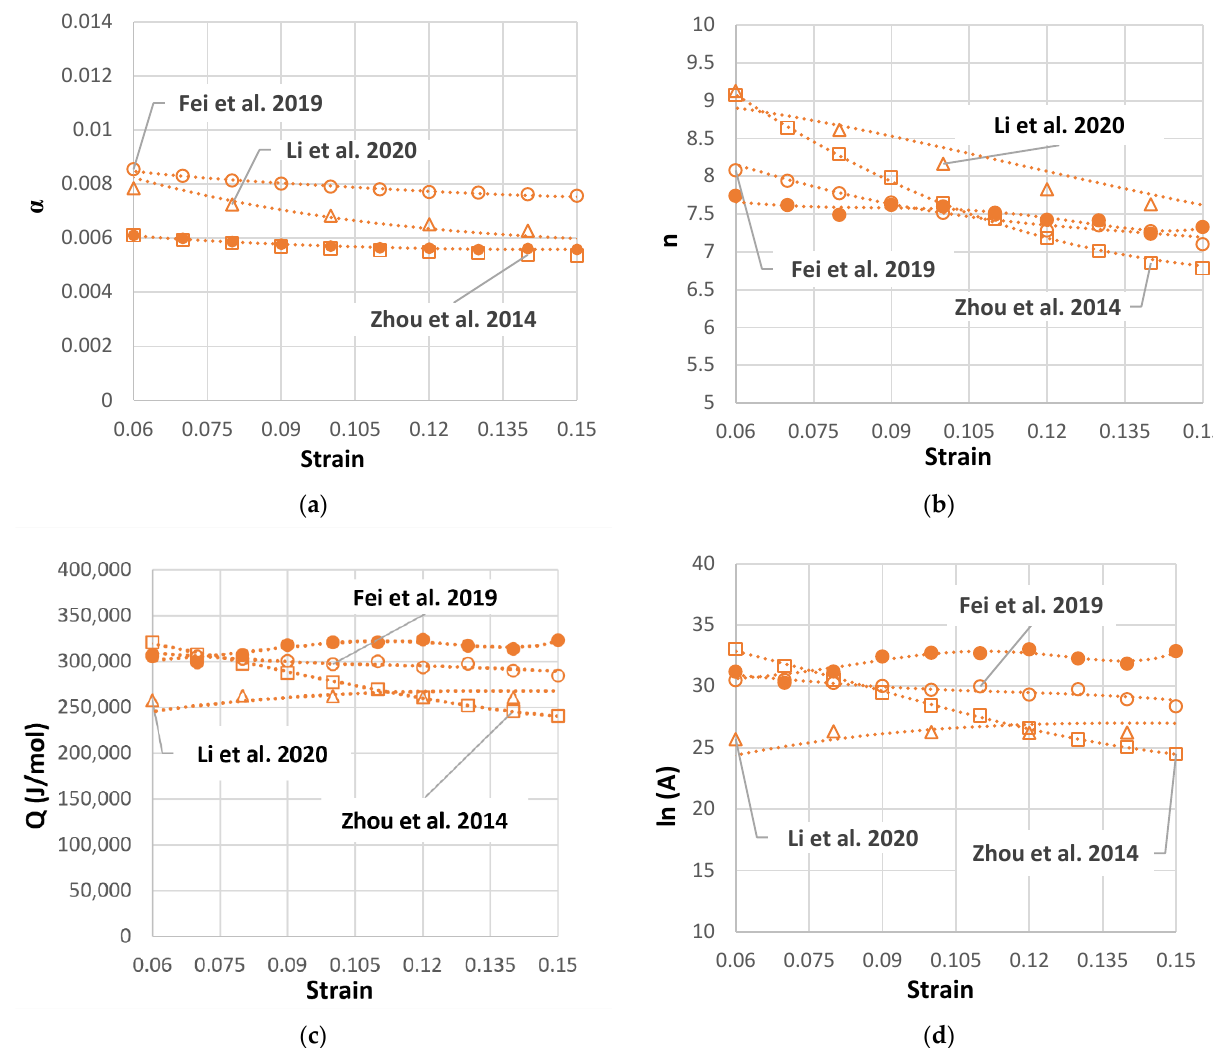
Figure 14. Polynomial fitting curves of material coefficients as a function of strain: ( a ) for 𝛼 ( b ) 𝑛 , ( c ) 𝑄 , and ( d ) ln(𝐴) for the USIBOR ® 1500.